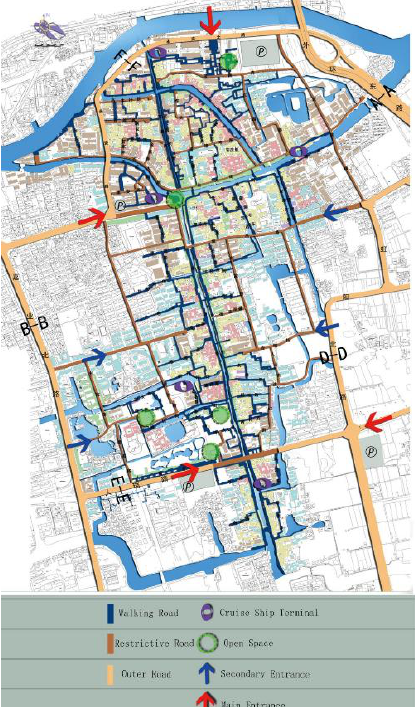
Figure 2. Road-network and waterway system plan in Nanxun.